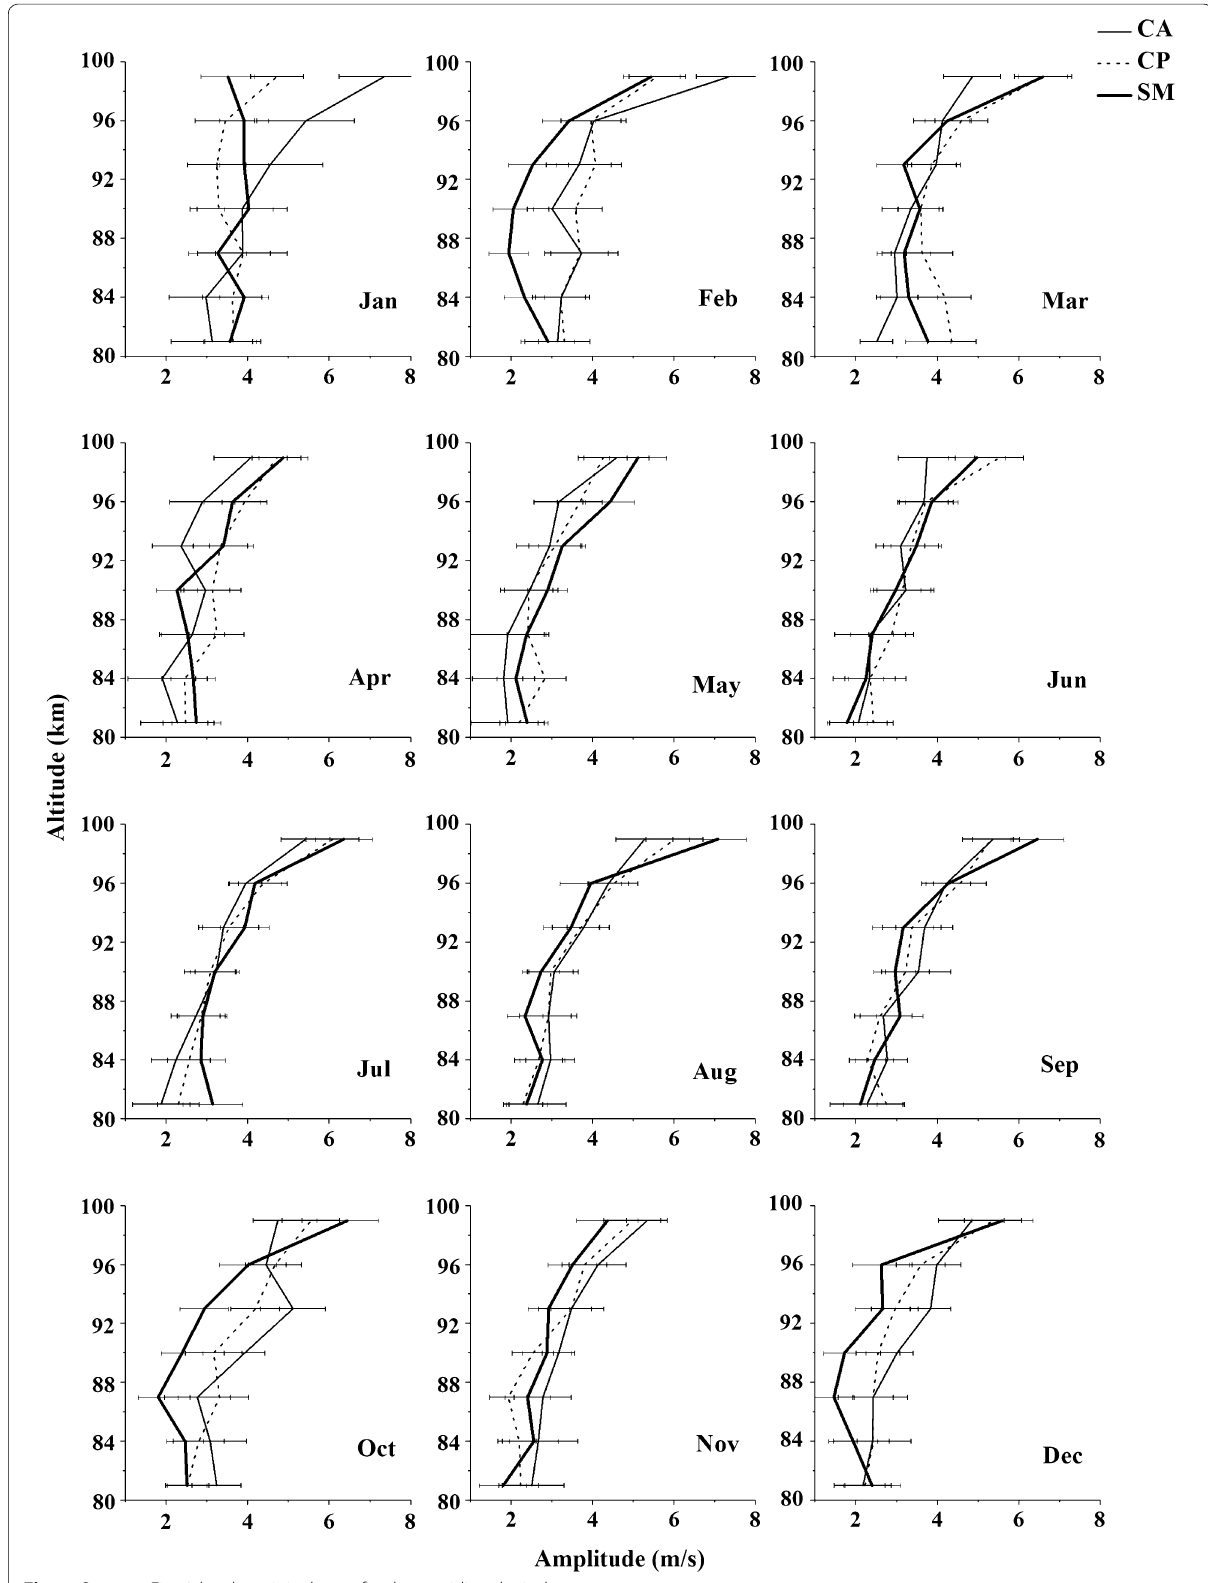
Fig. 7 Same as Fig. 6, but here it is shown for the meridional